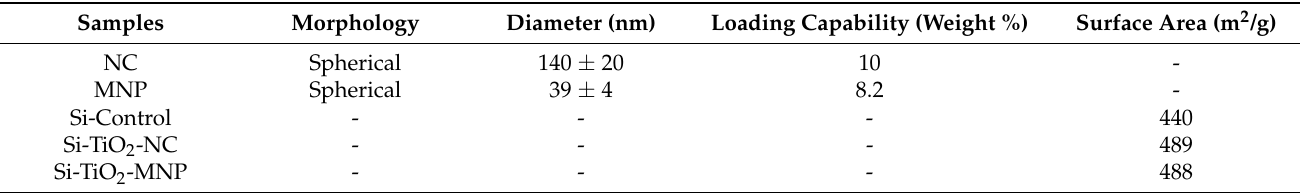
Table 1. Characteristics of silica nanocontainers and TEOS-based coatings. NC: silica nanocapsules; MNP: silica meso- porous nanoparticles. Si-Control, coating without nanoparticles; Si-TiO 2 -NC: coating with silica nanocapsules and TiO 2 nanoparticles; Si-TiO 2 -MNP: coating with silica mesoporous nanoparticles and TiO 2 nanoparticles.